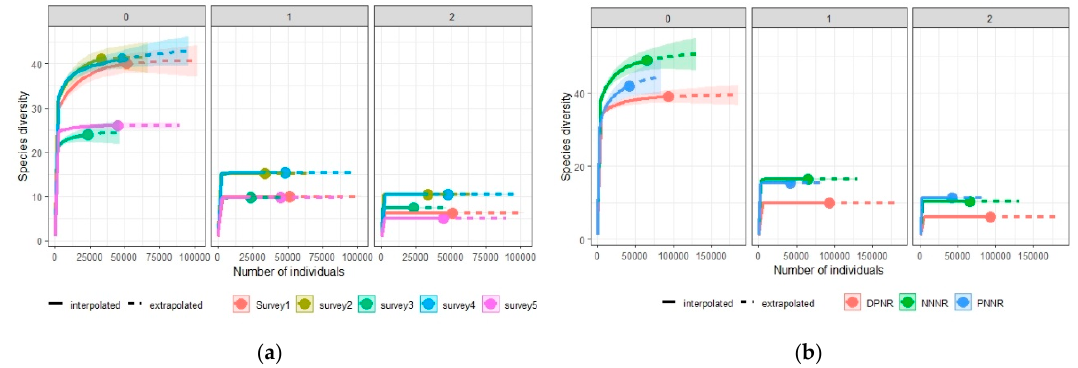
Figure 4. Abundance data-based rarefaction and extrapolation of Hill numbers for order q = 0,1,2 (species richness (q = 0), Shannon's diversity (q = 1) and inverse Simpson's diversity (q = 2)). For the entire five consecutive survey years ( a ) and for the three study site during the whole study periods ( b ). The solid line is the rarefaction curve and the dotted line is the extrapolation curve, which goes up to double the size of the reference sample. The shaded area represents 95% confidence intervals obtained using the bootstrap method based on the 200